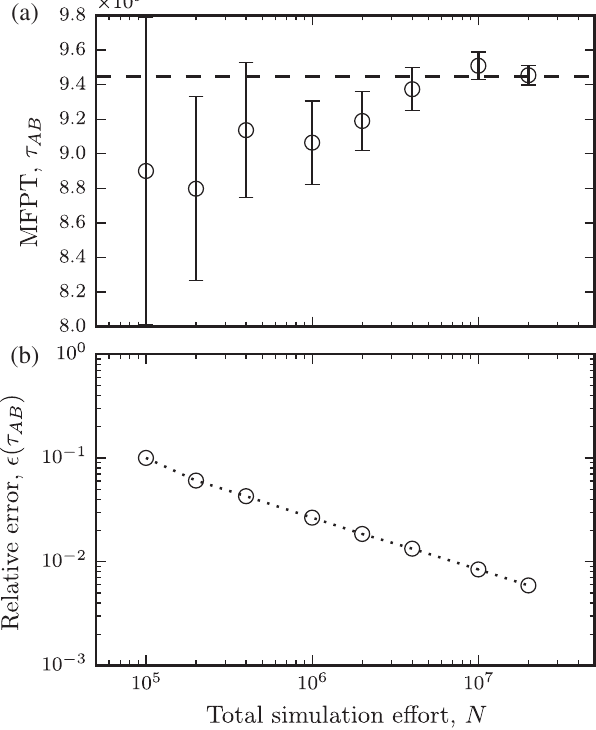
FIG. 11. Mean and standard error of mean first-passage time of vesicle dissociation on a coarse-grained non-Markovian state space. (a) Convergence of the mean value, (b) standard error. Estimates are obtained for an ensemble of association trajectories starting in the high-energy region and relaxing towards the low- energy region in combination with the coarse-grained equilibrium distribution. The dissociation time can be estimated orders of magnitude before a single dissociation event would have been